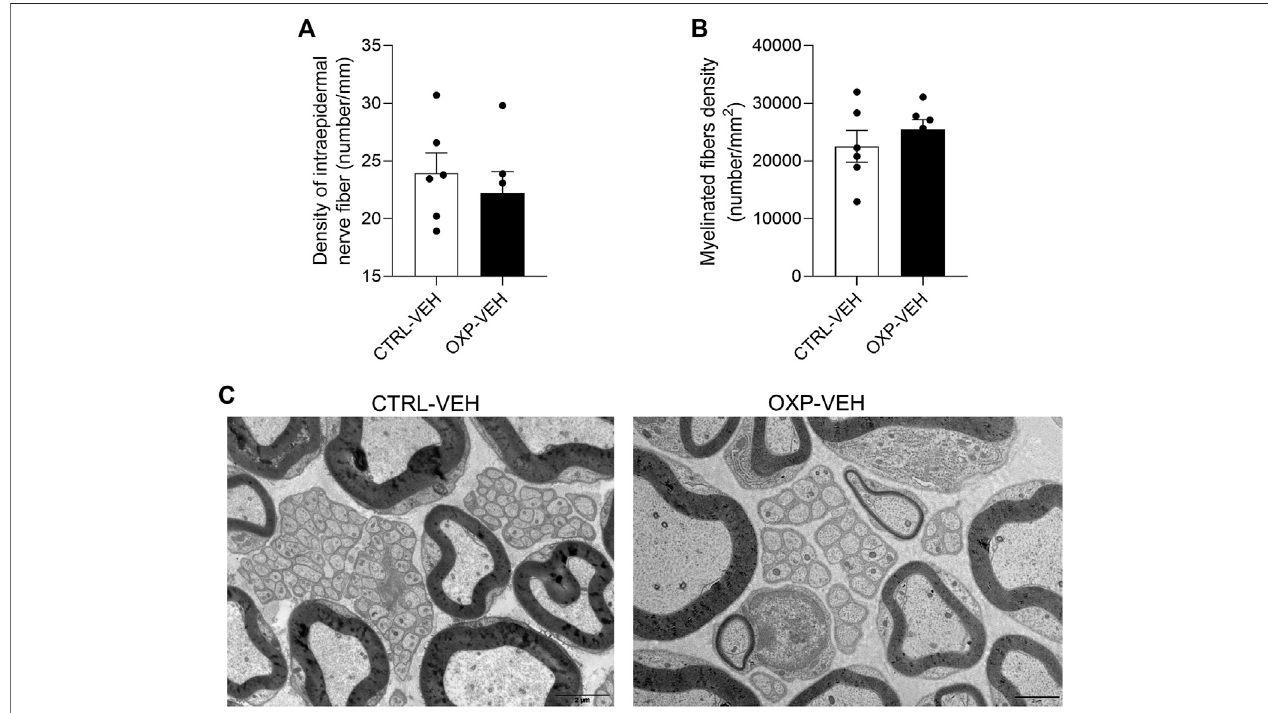
FIGURE 2 | Effect of OXP on peripheral nerve fi ber morphology. Footpad skin of CTRL-VEH and OXP-VEH mice were immunostained with PGP9.5 (A) Quanti fi cation of IENF positive for PGP9.5. Sciatic nerve fi bers were examined by electron microscopy. (B) Quanti fi cation of myelinated fi ber density. Analysis of three nervespergroupandfour fi eldsofviewpernerve (C) Visualizationofmyelinatedandunmyelinatednerve fi bersinthesciaticnerve.Scalebar (cid:1) 2 µm n (cid:1) 6micepergroup. OXP-treated mice received OXP at a cumulative dose of 15 mg/kg (5 mg/kg/3 days, intraperitoneal). CTRL: control, DRG: dorsal root ganglion, IENF: intraepidermal nerve fi ber, PGP9.5: protein gene product 9.5, OXP: oxaliplatin, VEH: vehicle.